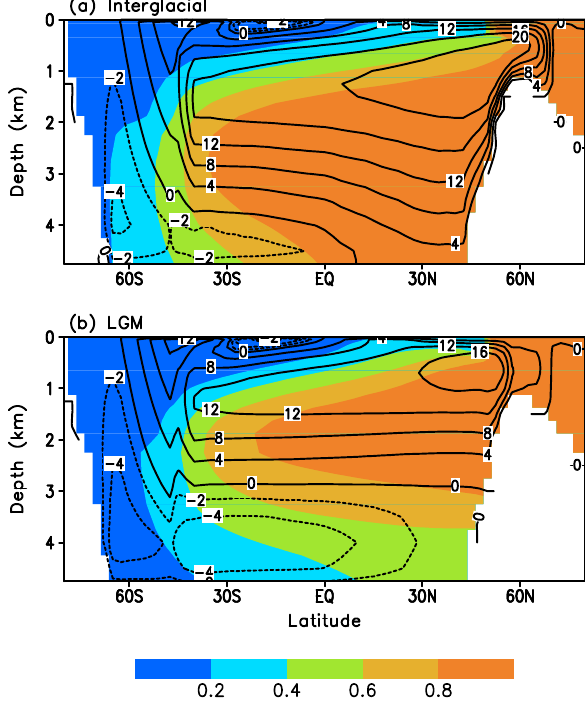
Fig. 9. “Dye” tracer concentration (shading) and meridional over- turning circulation (in Sv, contours) in the Atlantic for inter- glacial (a) and LGM (b) states. Northern water masses have a “dye” concentration of 1 and the southern water masses of